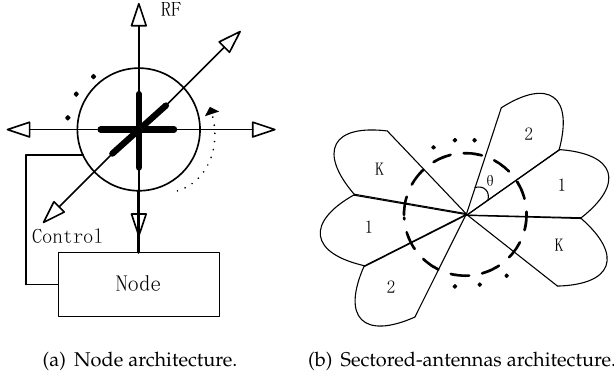
Figure 6. Node and sectored-antennas architecture of bi-directional (BD)-SBA